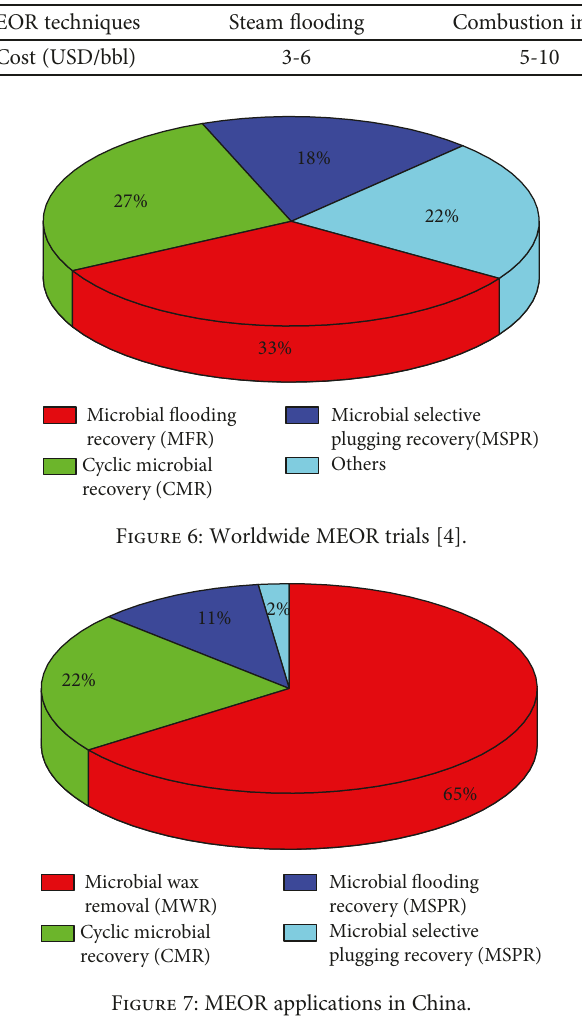
Table 1: Cost per incremental oil for di ff erent EOR techniques [5].